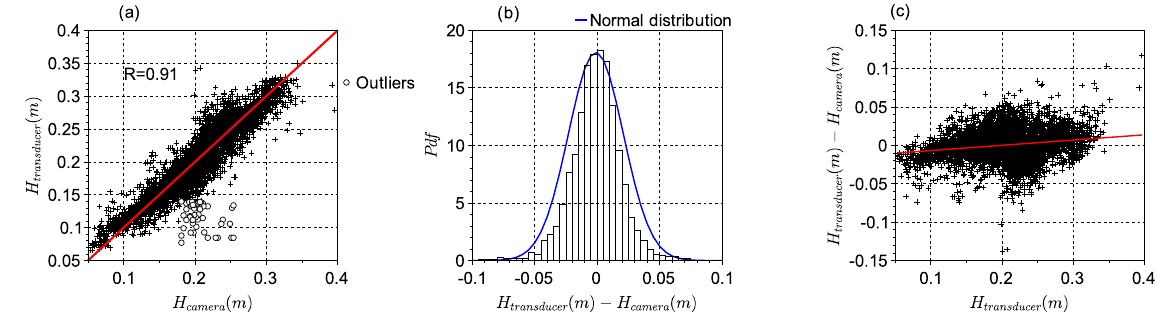
Figure 9. a )Comparison of the transducer data set ( H transducer ) and the camera data set ( H camera ) on the scatter plot; the cluster of outliers point represented with open symbols has been manually checked and corresponds to waves at the pressure transducer. (b) The error distribu- tion; the normal distribution is set to a mean value of 0 . 00m and a standard deviation of 0 . 02m. (c) The residual plot of H transducer – H camera with regard to H transducer ; the red line represents the linear regression, showing a tilt on the water depth estimation. At high discharges, the camera data set underestimates the transducer data set and at low discharges the camera data set overestimates the transducer data set.